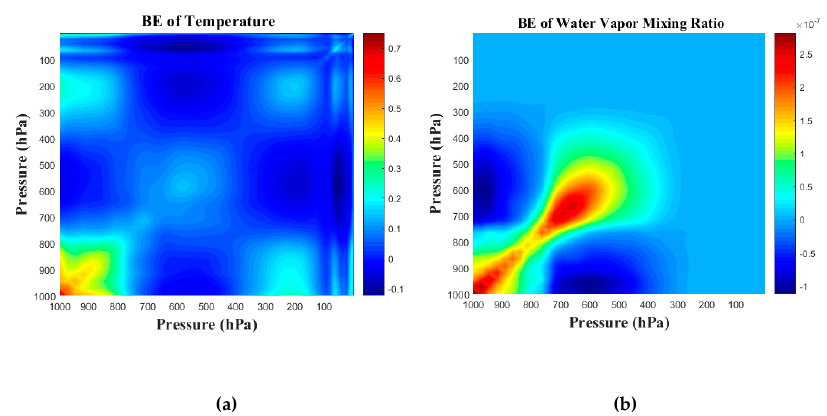
Figure 5. ( a ) The temperature background error (BE) covariance matrix of the Beijing region (in units of K 2 ) and ( b ) the water vapor mixing ratio background error covariance matrix of the Beijing region (in units of (g/kg) 2 ).